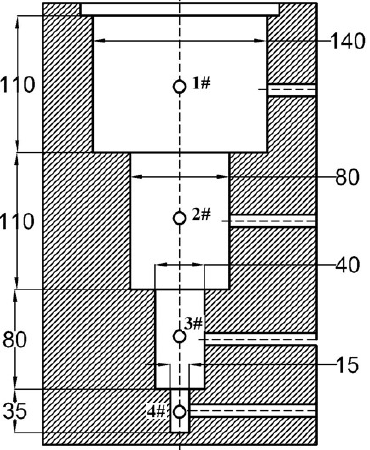
Figure 1. Schematic diagram of experimental casting mold.